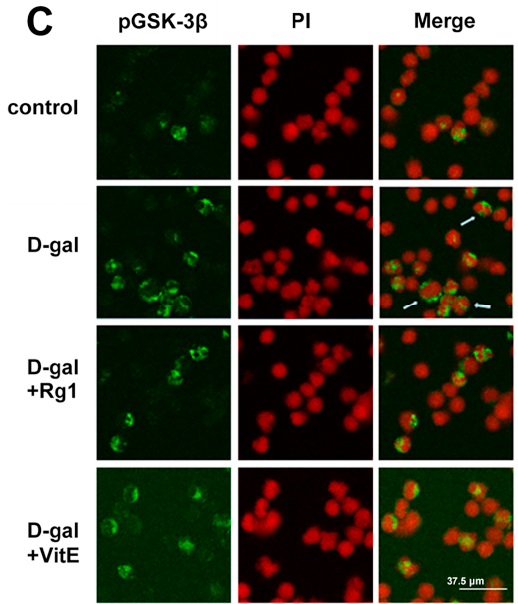
Figure 4. Effects of ginsenoside Rg1 on GSK-3 β and pGSK-3 β expressions of Sca-1 + HSC/HPCs from D -gal-induced aging mice. ( A ) GSK-3 β and pGSK-3 β expressions are shown by Western blot. β -actin was the internal control protein; ( B ) The ratio of pGSK-3 β /total GSK-3 β is shown. The pGSK-3 β /total GSK-3 β levels increased in the D -gal model group compared to the control group and D -gal + Rg1 group; ( C ) Immunofluorescence staining of pGSK-3 β is shown. The pGSK-3 β expression was strong in the D -gal model group compared to the control group, but was decreased after treatment with Rg1 and VitE. Green indicates pGSK-3 β mAb in the cytoplasm, which was pointed out by the arrow in the diagram. Red indicates nuclei stained by PI. Scale bar = 37.5 μ m. (mean ± SD, n =3; # p < 0.05, ## p < 0.01 vs. the control group, * p < 0.05 vs. the D -gal model group).